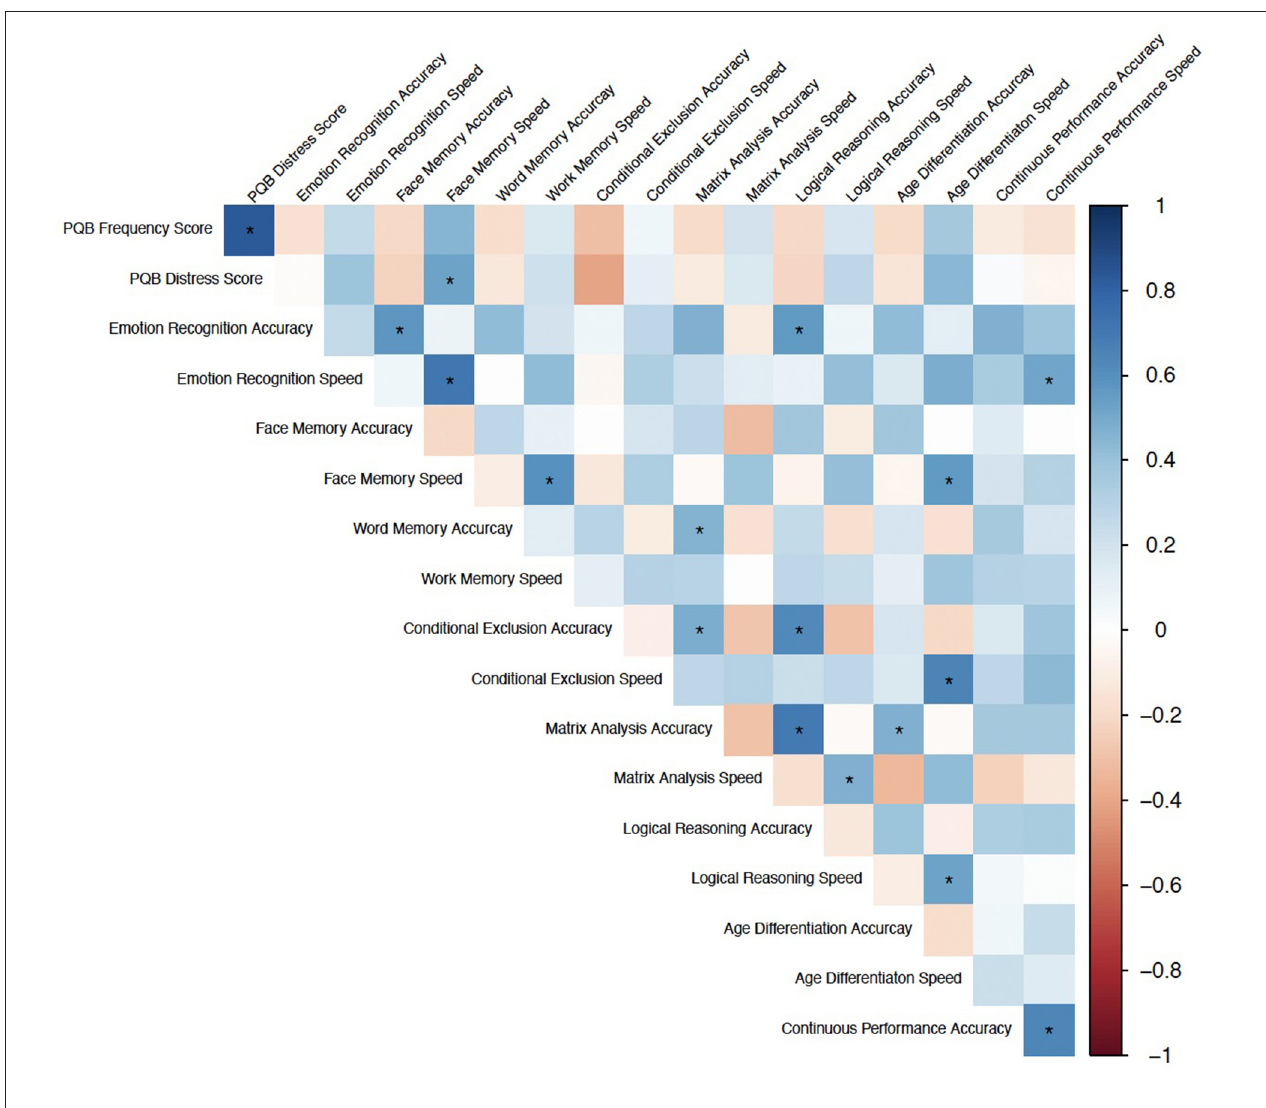
FIGURE 4 | Spearman Correlations between neurocognitive domains (accuracy and speed) and PQ-B frequency and distress scores. Color indicates correlation coefficient, *Indicates q < 0.05.